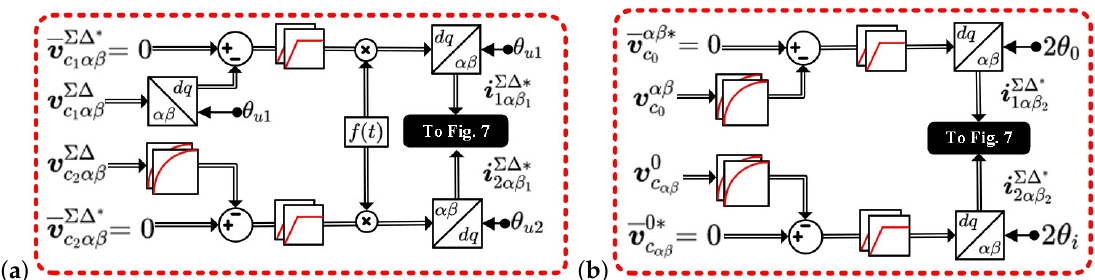
Figure 6. ( a ) EFM control strategy of v Σ∆ c control strategy of v αβ c